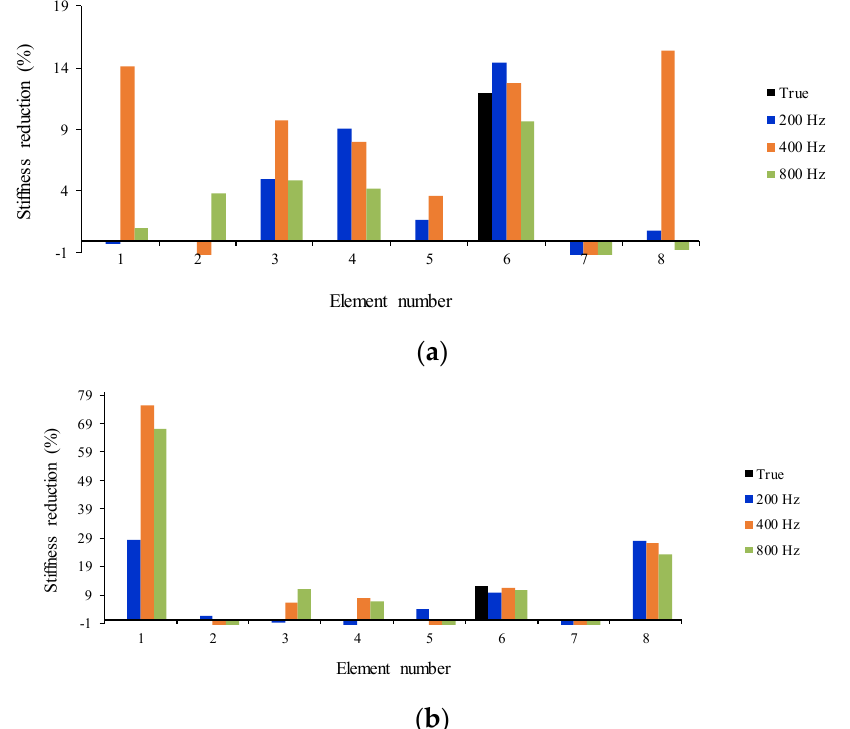
Figure 20. The effect of sampling frequency on damage detection- Damage case 1. ( a ) Speed: 0.47 m/s; ( b ) Speed: 0.94 m/s.